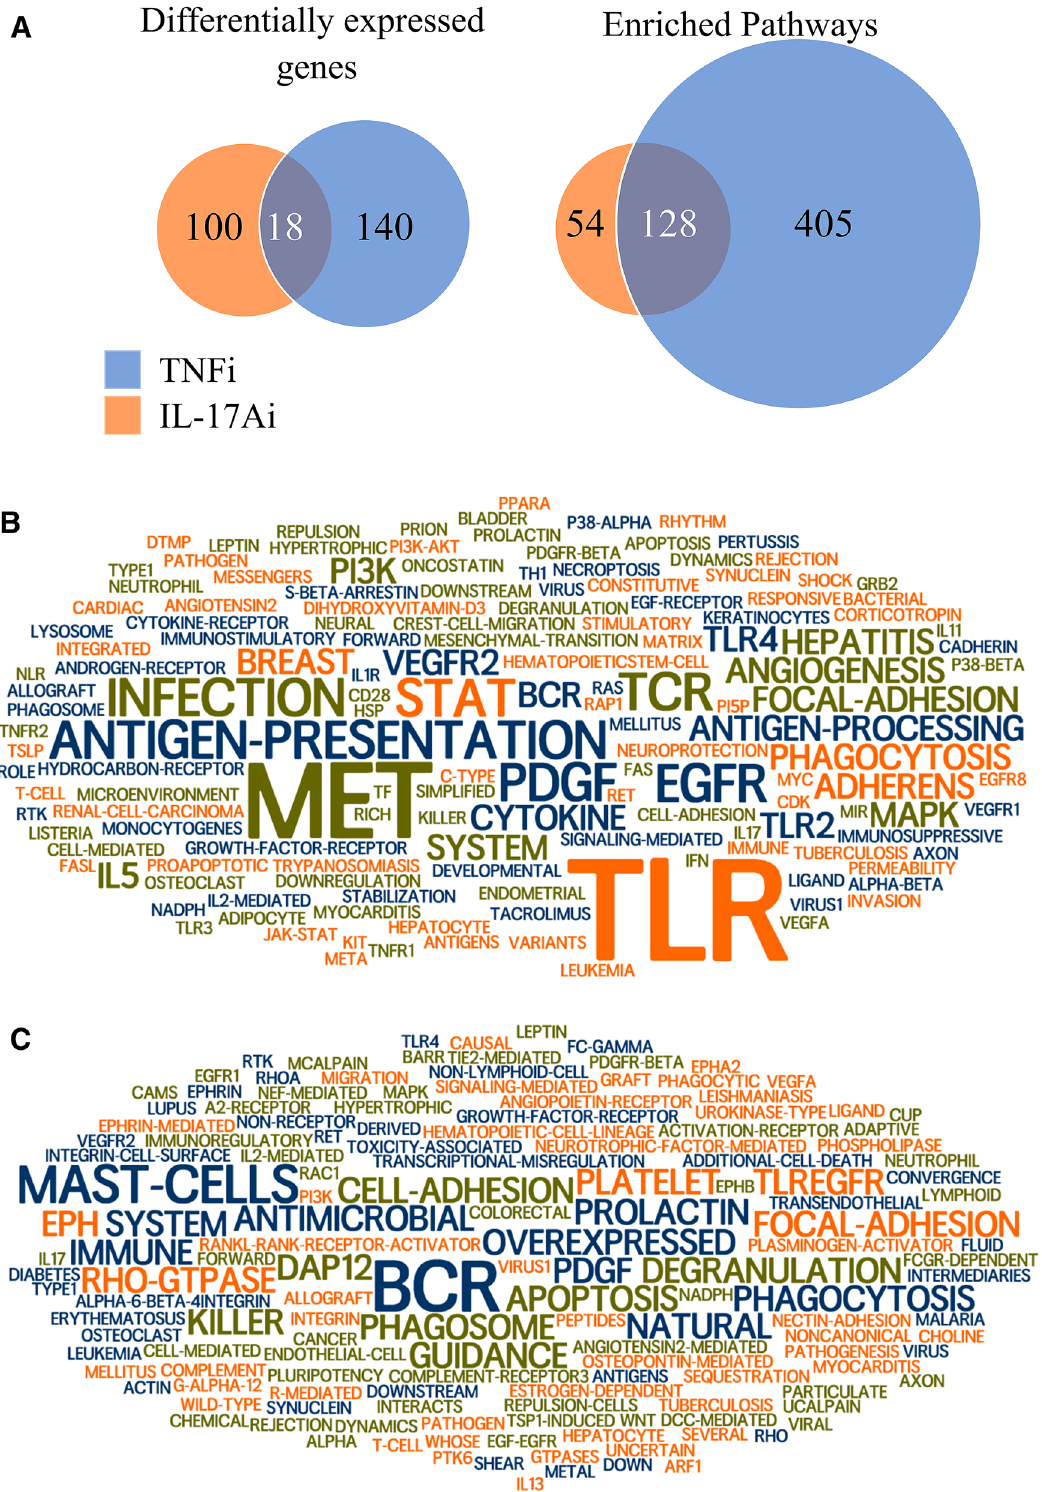
Figure 3. Pathway enrichment analysis of selected DEGs using PPI network. ( A ) Overlap of DEGs between response groups to each biologic at baseline and their enriched pathways. ( B , C ) Key-terms of pathways enriched in DEGs between response groups to ( B ) TNFi and ( C ) IL-17Ai. Size of the terms is proportional with statistical significance of each term in titles of enriched pathways. Colors are different only for clarity. While most of the large terms in each panel are present in the other panel in a different size, MET, JAK, STAT in panel B, and, Rho- GTPase and EPH in panel C are absent from the other panel. Thus, high deregulation of these pathways between responders and non-responders is specific to one of the two